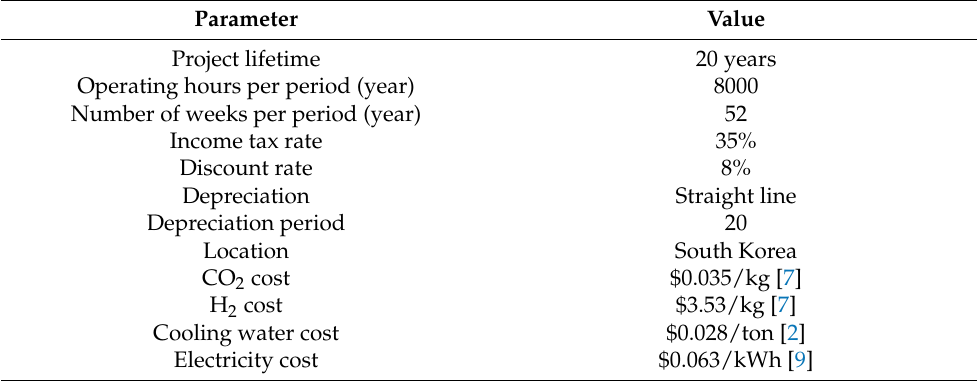
Table 4. Summary of economic parameters assumptions.